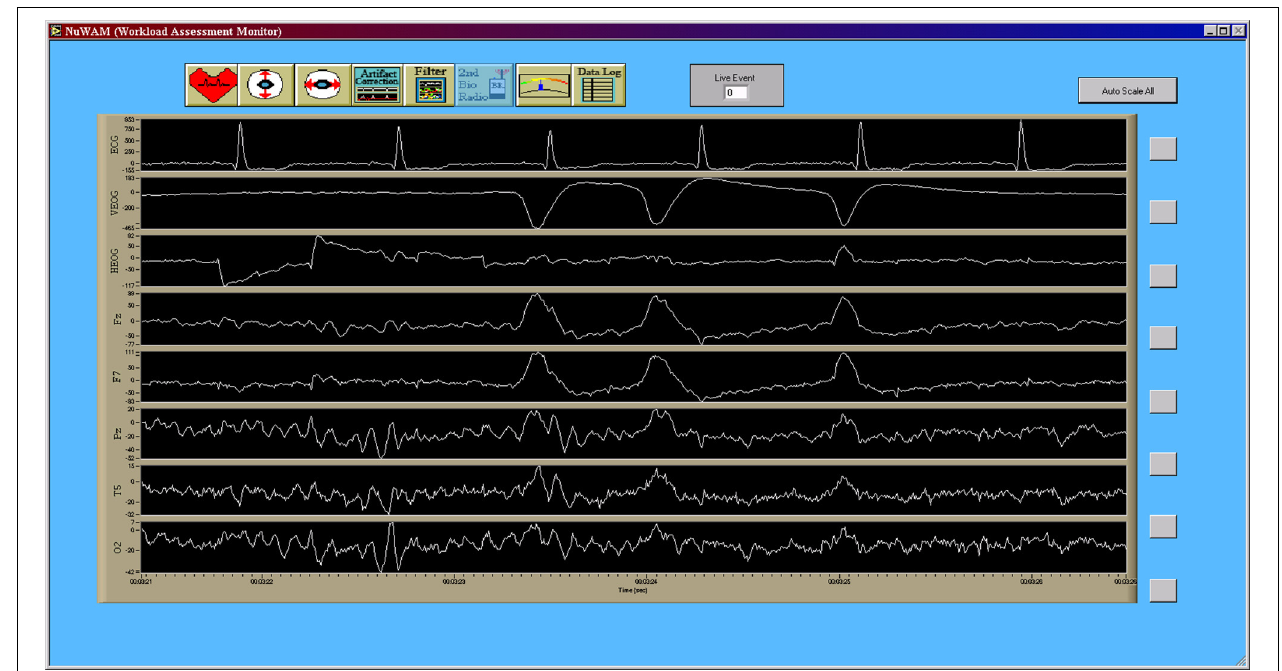
FIGURE 4 | Primary data collection user interface for the custom data acquisition software. This interface allows researchers to view the raw time series, in real-time, during data acquisition in order to monitor data quality. Note that the seventh channel, T5, is the original convention presented by Jasper (1958) for what is now commonly referred to as P7 (Chatrian et al.,